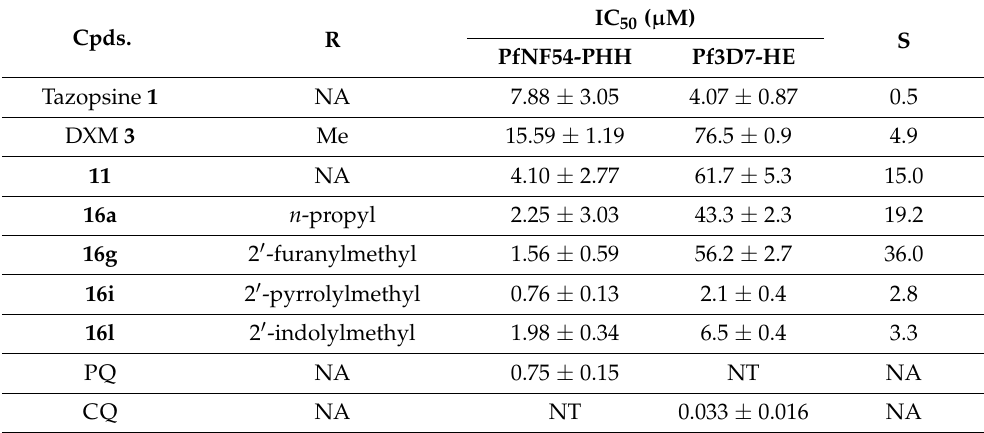
Table 4. In vitro IC 50 values of tazopsine 1 , DXM 3 , and selected N -modified derivatives against P. falciparum liver (NF54) and blood (3D7) stages, as well as liver phase selectivity values (S). IC 50 values are the mean of four technical replicates for PHH and three technical replicates for HE. R identities for N -substituted DXM 3 derivatives refer to Figure 4. HE: human erythrocytes; NT: not